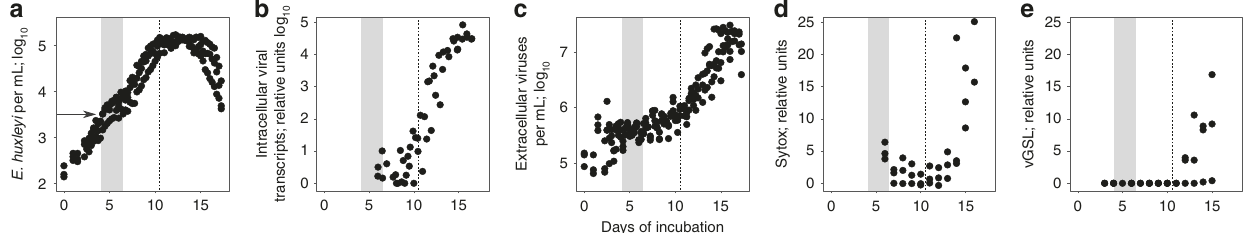
Fig. 5 Temperate dynamics in natural E. huxleyi populations. Dynamics in a E. huxleyi cell abundance (sampled days 0 – 18; n = 191 counts across three replicate mesocosms), b intracellular EhV transcription (relative units; Pagarete et al. 55 ; units from original paper; n = 50 counts across three